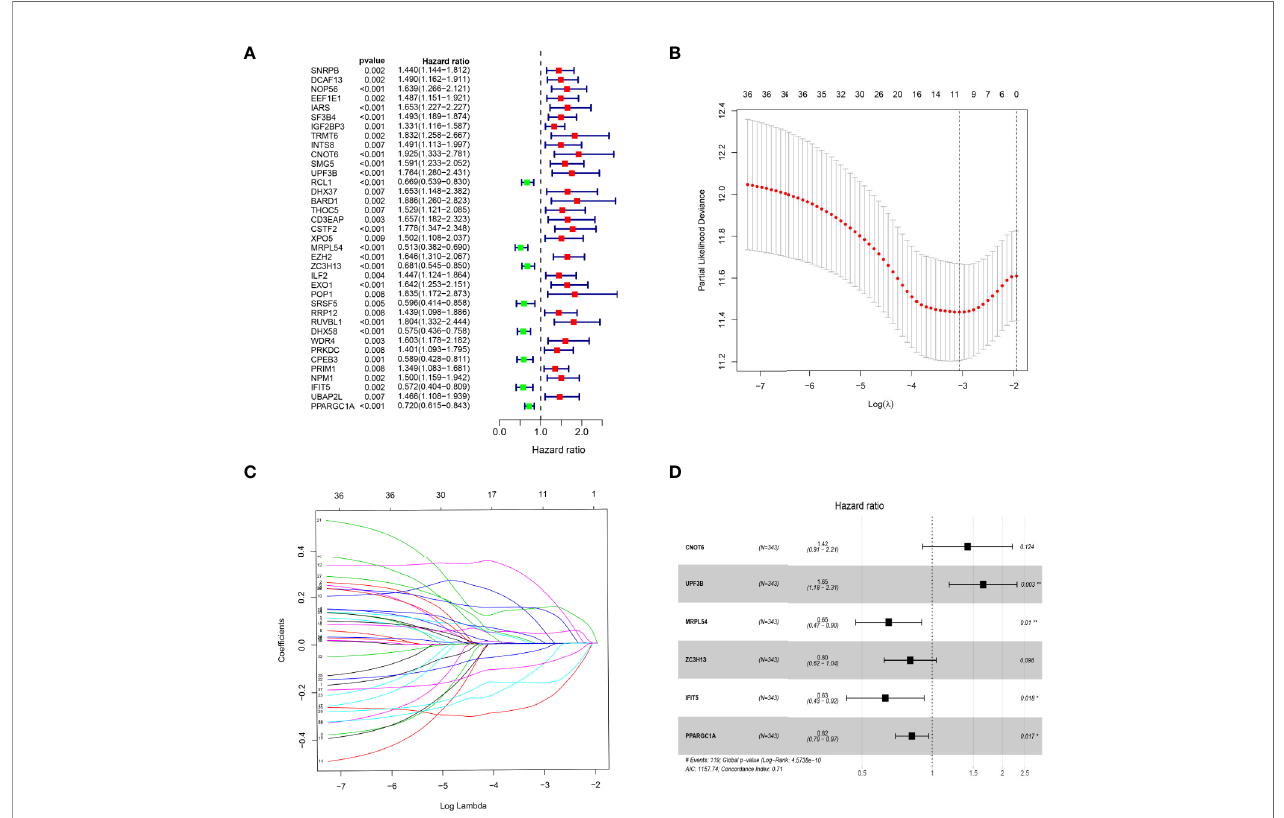
FIGURE 4 | Selection of prognosis-related RBPs in the training cohort. (A) Univariate Cox regression analysis; (B, C) LASSO regression analysis; (D) Multivariate Cox regression analysis to screen out the key RBPs most relevant to